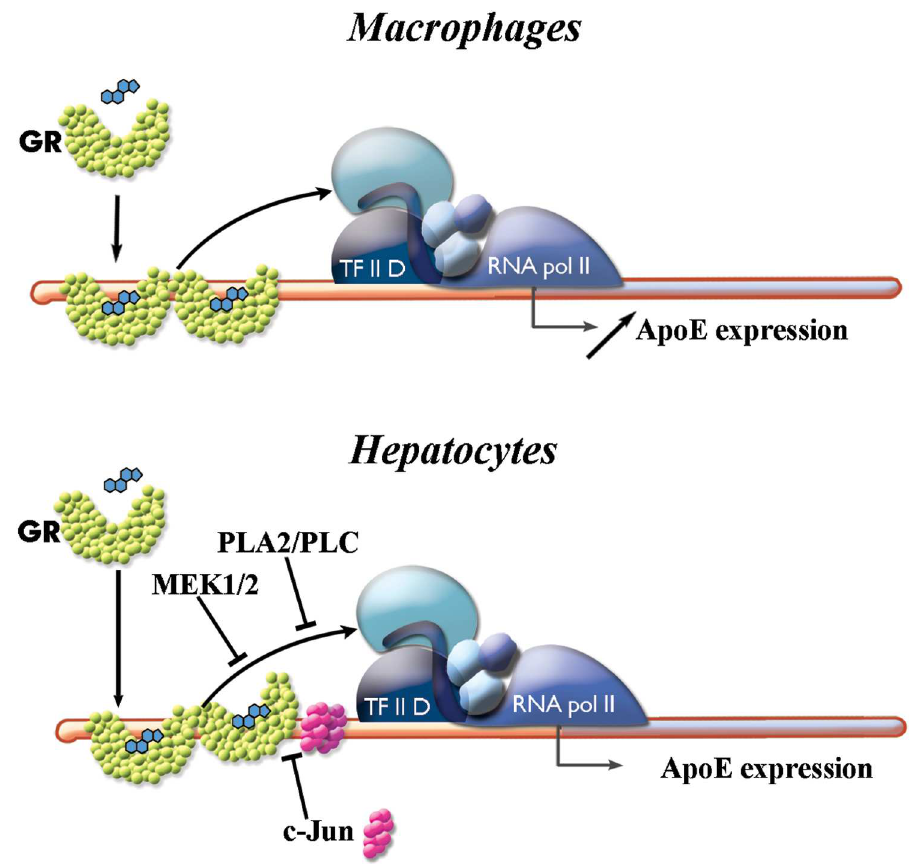
Fig 8. Schematic representation of cell-specific modulation of apoE gene expression by ligand- activated glucocorticoid receptors (GRs). In macrophages, ligand-activated GR binds to its specific site locatedon apoE proximalpromoter leadingto an increasein apoE promoter activity and enhancingapoE transcription. In hepatocytes, despitethe direct interaction betweendexamethasone-activatedGR and apoE promoter, GR cannot modulateapoE transcription.The bindingof c-Jun on its specific site located next to the GR bindingsite inhibitsonly partially GR binding. MEK1/2 and PLA2/PLCsignalingalso contributesto the inhibitionof GR action on apoE